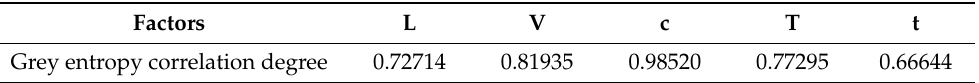
Table 8. Grey entropy correlation between active component residual and influencing